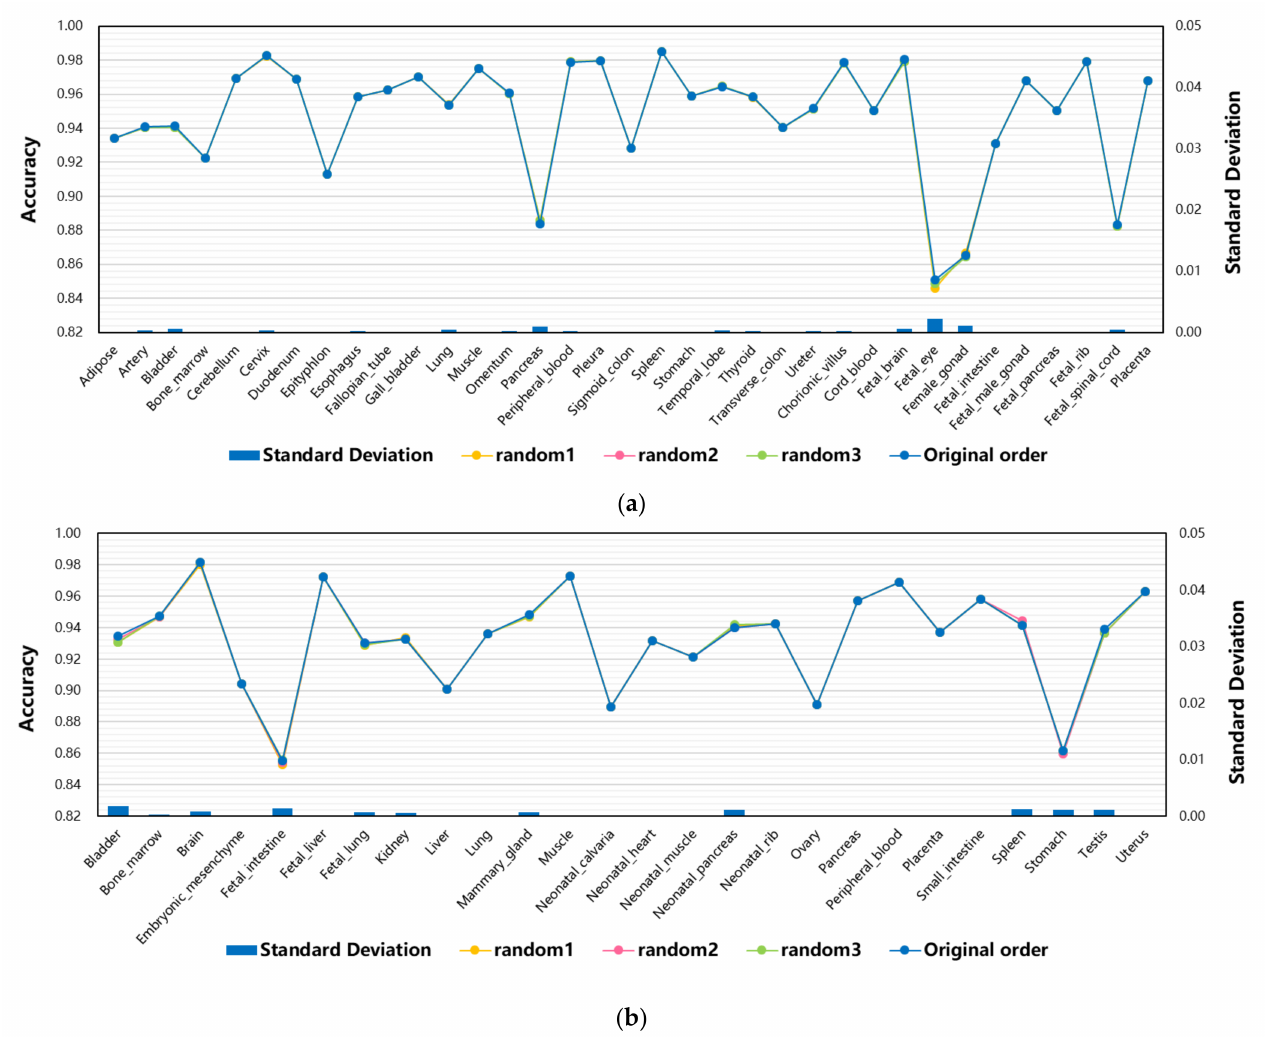
Figure 7. Performance of scTransSort under different inputs. ( a ) Experiments on cells containing 35 human tissues; ( b ) Experiments on cells containing 26 mouse tissues. The line chart shows the accuracy of cell classification predictions for each group of data under different input modes. Each color line represents a specific input mode. The bar chart displays the standard deviation of the results obtained with different